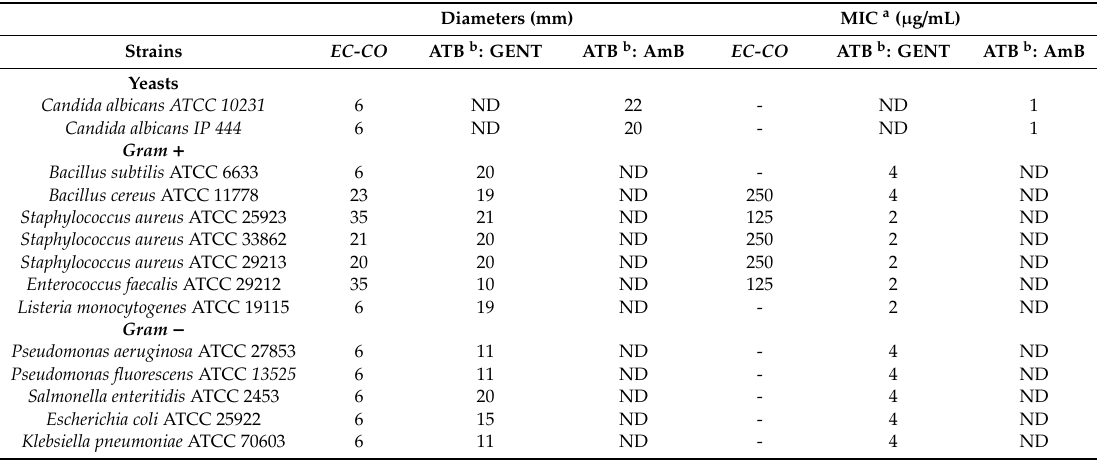
Table 4. Antimicrobial activities of E. campestre collective essential oil expressed by the diameter inhibition zones and MIC values ( µ g /